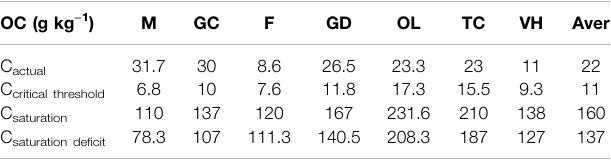
TABLE2| Theactualcontent,criticalthreshold,saturationpoint,andde fi citofOC of